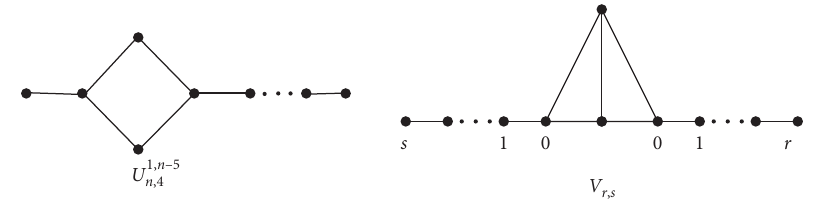
Figure 1: The graphs U 1 ,n − 5